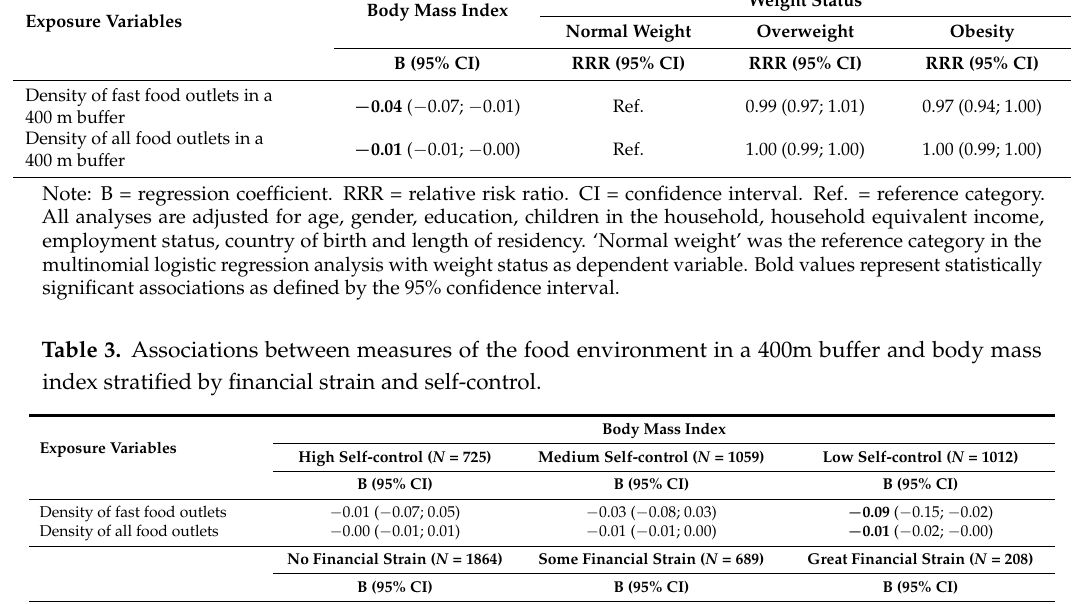
Table 2. Associations between measures of the food environment and body weight. Exposure Variables